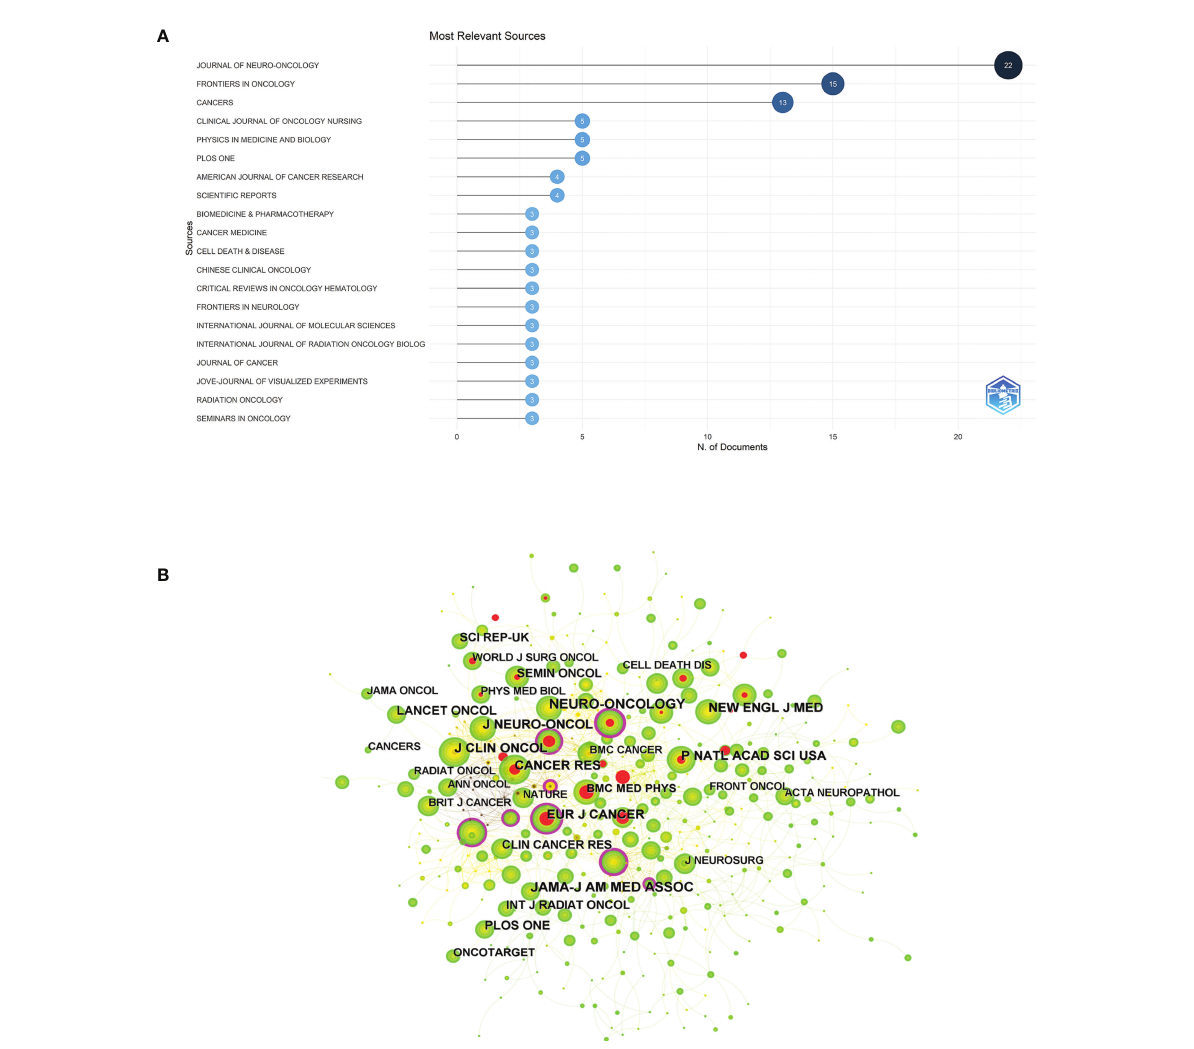
FIGURE 5 (A) Visualization mapping of the top 20 source journals for related publications. (B) Visual mapping of co-cited journals of related publications. A circle represents a co-cited journal, the larger the circle the higher the citation frequency of the co-cited journal, and the purple ring of the outer ring represents a high